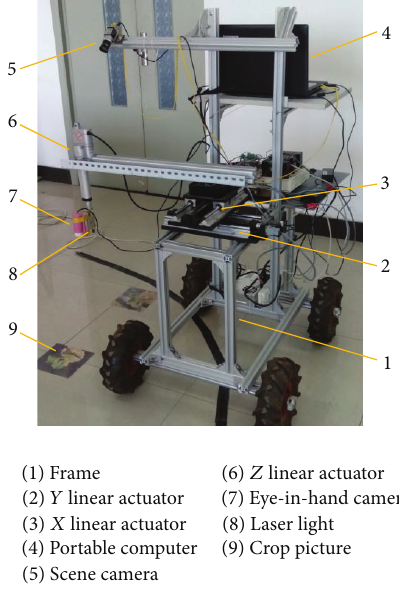
Figure 9: Experimental